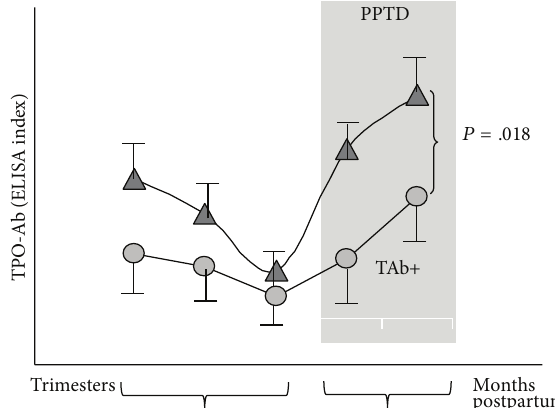
Figure 2: Thyroid antibody levels throughout pregnancy. There is a fall in thyroid autoantibodies reaching its nadir in the third trimester, before rebounding postpartum, in what is clinically seen as postpartum thyroid disease (PPTD: postpartum thyroid disease). Reproduced from